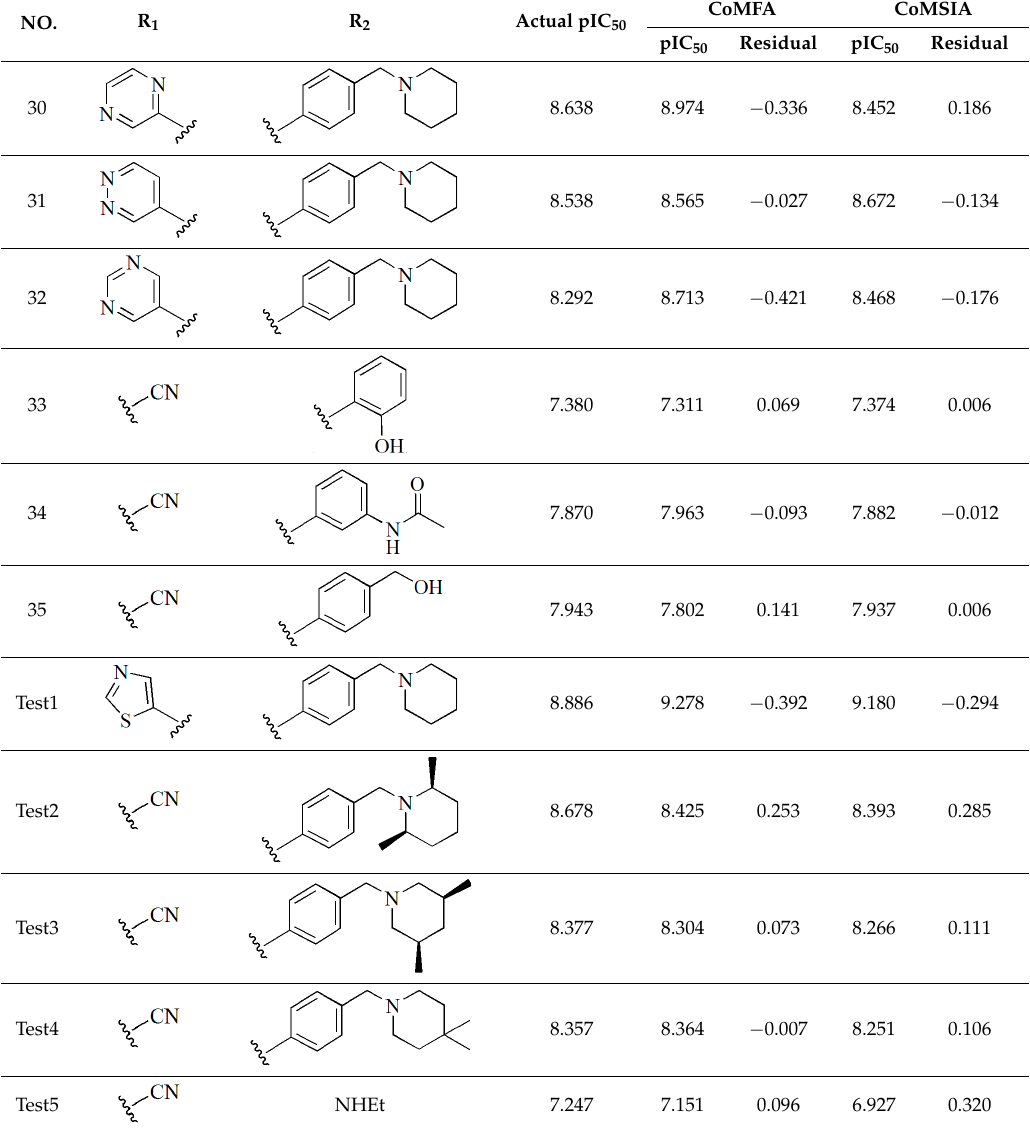
Molecules 2016 , 21 , 591 3 of 15 Table 1. Chemical structural formulas of all structures. Statistical parameters of the actual and predicted bioactivity by CoMFA and CoMSIA, as well as the residual between the actual and predicted pIC 50 values. All the aligned molecular dataset used for the 3D QSAR studies were shown in Table S1 in the supplementary materials